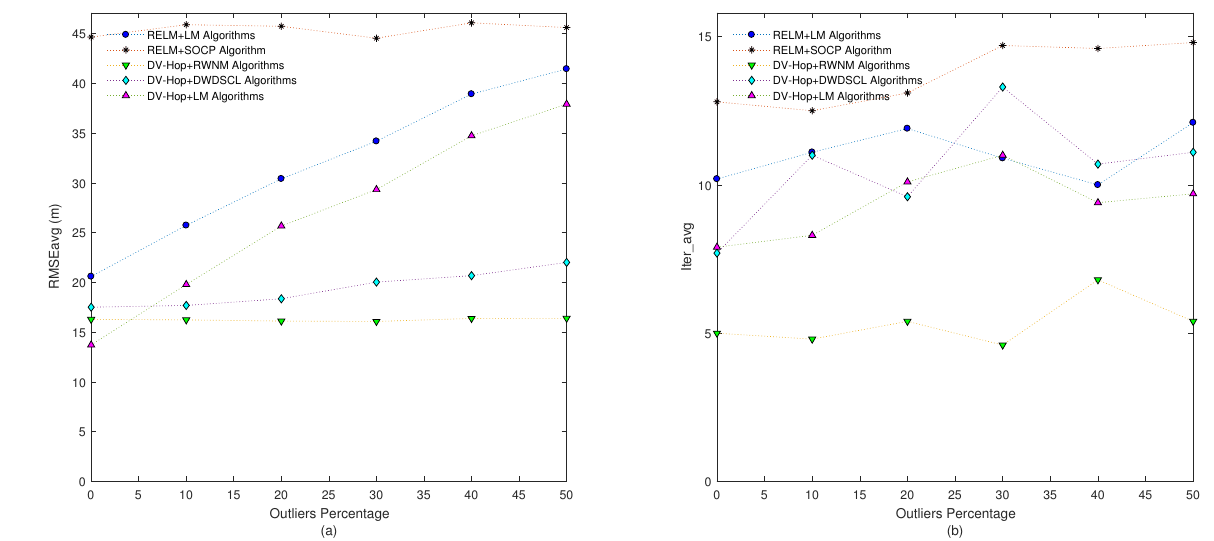
Figure 10. ( a ) RMSEavg and ( b ) Iter _ avg after running five iterative algorithms over 10 multi-hop anisotropic networks with R = 45 m and nfe = 0.1. Outliers levels are increased by steps of 10% from 0% to 50%.